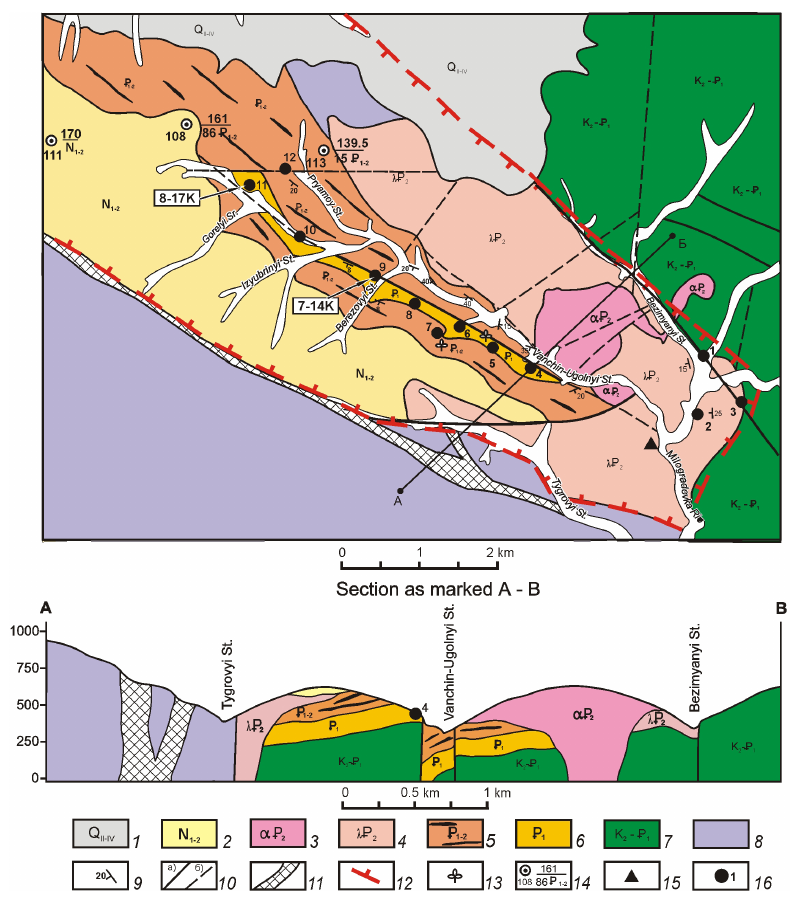
Figure 6. Geological map and transverse cross section of the Vanchinskaya coal-bearing basin: 1 – Quaternary deposits; 2 – Eocene con- glomerates and sandstones; 3 – Eocene trachyandesites and trachydacites; 4 – Eocene rhyolites and rhyolite tuff; 5 – Eocene carbon-rich terrigenous and volcano-sedimentary deposits (argillites, siltstones, sandstones, tuffaceous sandstones, conglomerates, sometimes with in- terbeds of brown coal and rhyolite tuffs); 6 – Palaeocene volcanogenic-sedimentary deposits (tuffaceous siltstones and sandstones with interbeds of rhyolite tuffs); 7 – Upper Cretaceous to Palaeocene poorly defined undifferentiated formations (predominantly felsic to inter- mediate and mafic volcanic units); 8 – pre-Mesozoic sedimentary and volcanogenic deposits (predominantly siltstones and sandstones); 9 – dip and strike of rock; 10 – faults: determined (a), assumed (b); 11 – tectonic breccia zones; 12 – assumed border of the basin; 13 – sampled localities of fossilised flora; 14 – shafts and drill holes; 15 – archaeological site; 16 – the most prominent